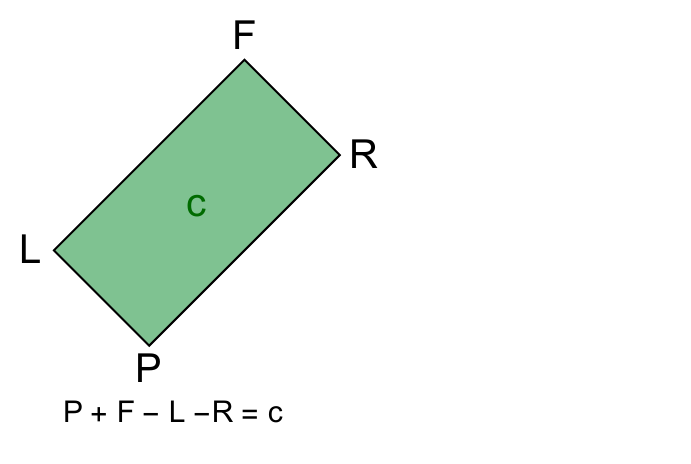
Figure 5 . A causal diamond is associated to a “Gauss law” involving variables sitting at its corners.